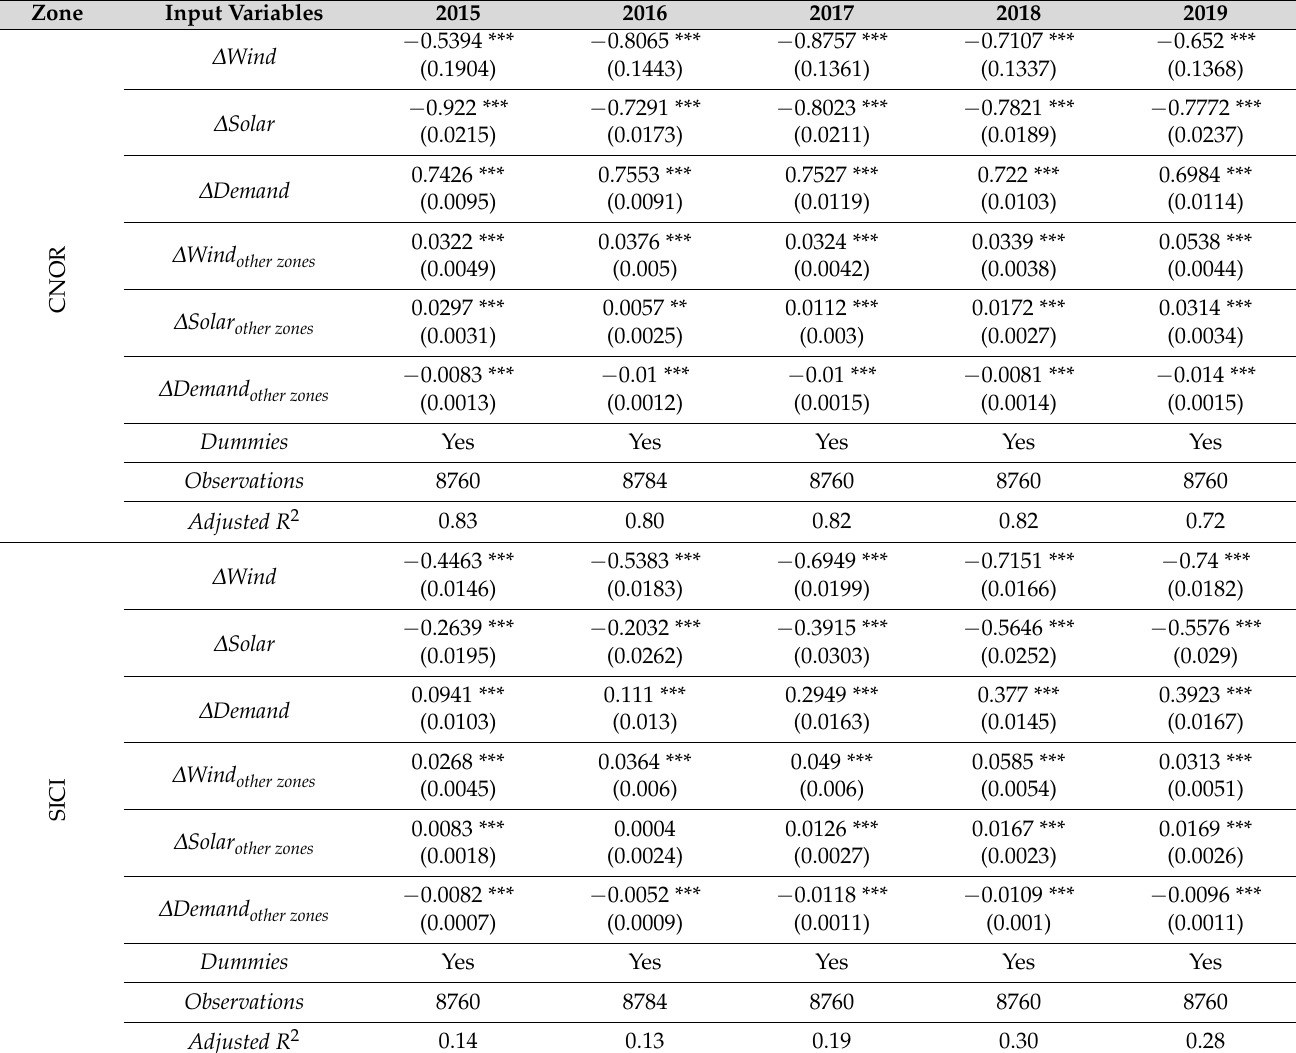
Table 1. OLS estimation of hourly changes in net input flow of CNOR and